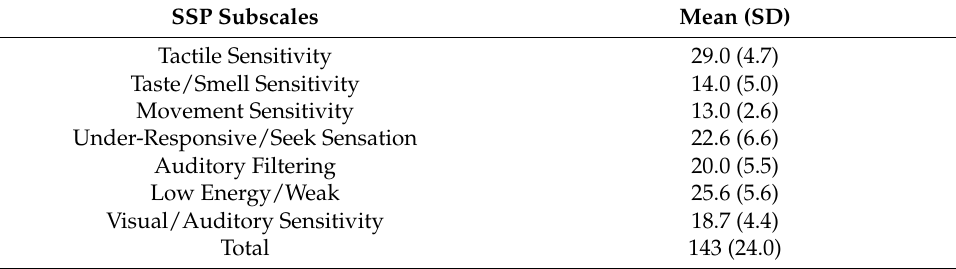
Table 2. Short Sensory Profile (SSP) mean subscales and total